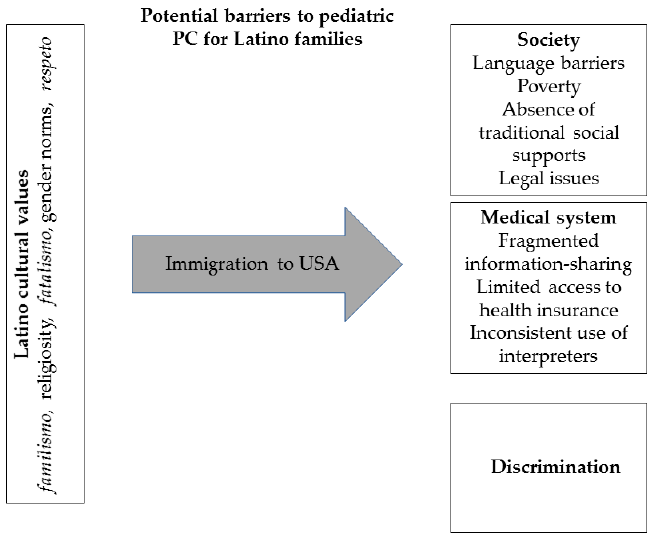
Figure 1. Mediators of the pediatric palliative c are (PC) experience for latino families.